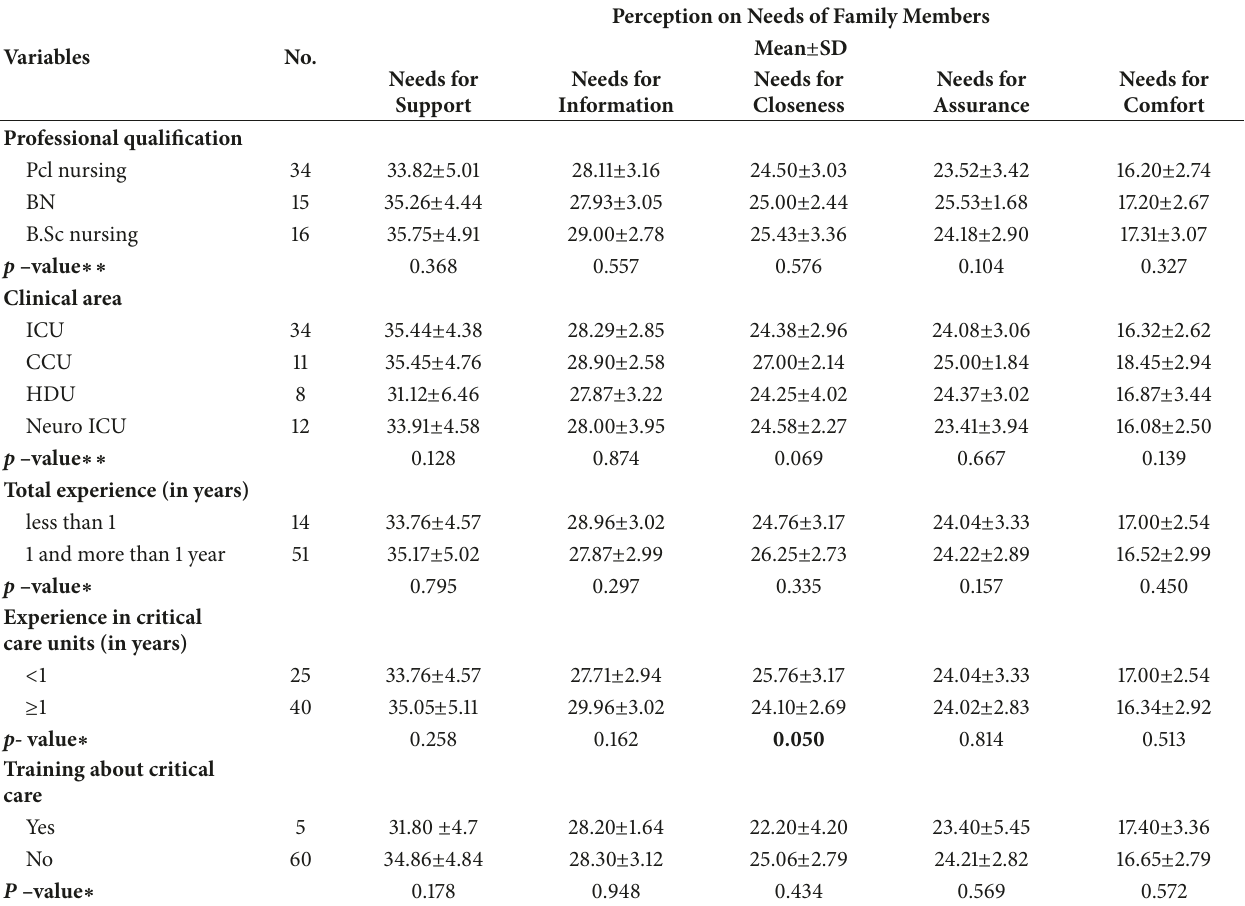
Table 7: Differences on perception of nurses on needs of family members according to professional characteristics.